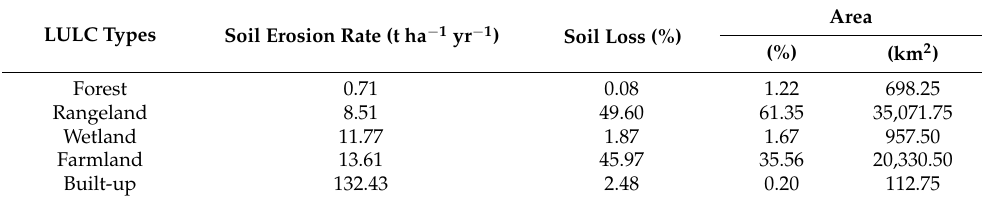
Table 5. Soil erosion of the different LULC types for the